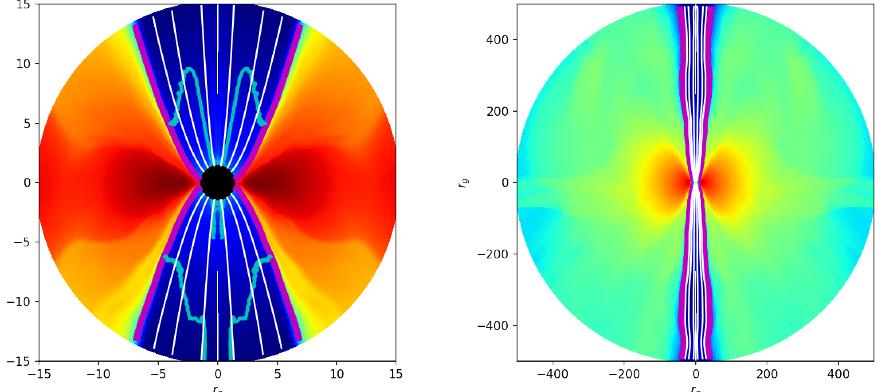
Figure 1. Examples of magnetic field configuration from a 2D GRMHD simulation for accretion flow with negligible radiation feedback, with small (left panel) and large (right panel) fields of view. The black hole rotational axis is aligned with that of the accretion flow. Black hole-threaded, ordered, large-scale magnetic fields (indicated as white lines) are developed along the black hole rotational axis, enclosed by the contours of σ ≡ B 2 / ρ c 2 = 1 (purple lines). Magnetic field configurations in the region where σ < 1 are not shown. The contours for u r = 0 (a radial component of the fluid’s four velocities) are shown as cyan lines. Relativistic jets are launched from the funnel region at the expense of the rotational energy of black holes. The color shows the density on a logarithmic scale, with blue and red representing small and large densities,